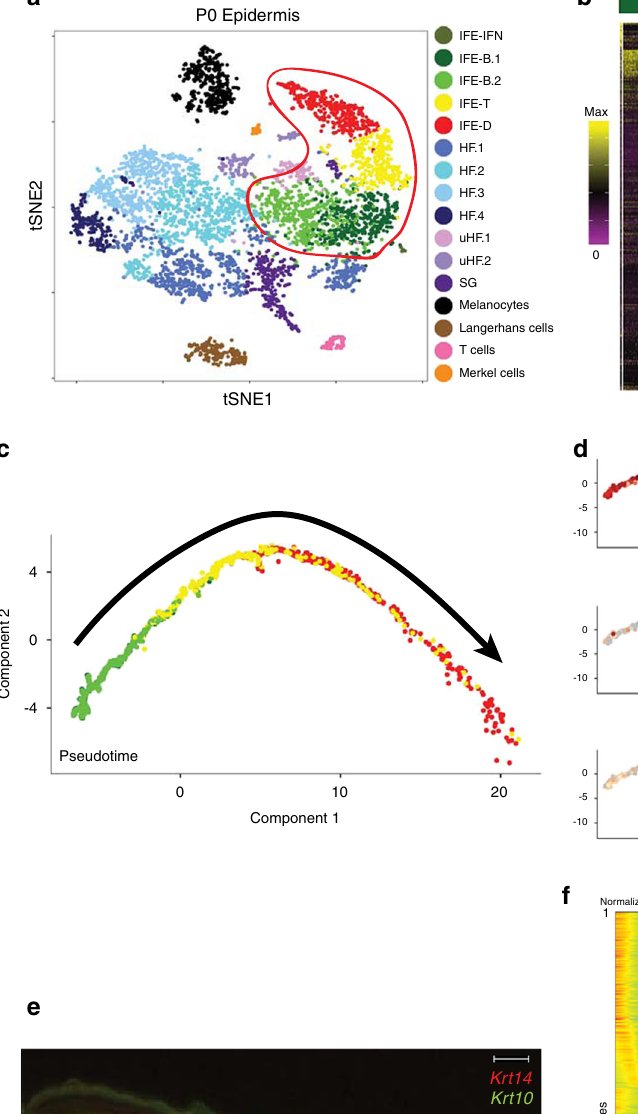
genes that are dynamically expressed over the pseudotime trajectory. K-medoid clustering grouped these genes into six gene modules with distinct expression patterns and biological functions (Fig. 1f) 9,10,14 . Module 1, high early and falls sharply, is enriched in genes associated with cell proliferation. Module 2, also high early but falls more slowly, is enriched in genes involved in transcription and mRNA processing. Module 3,